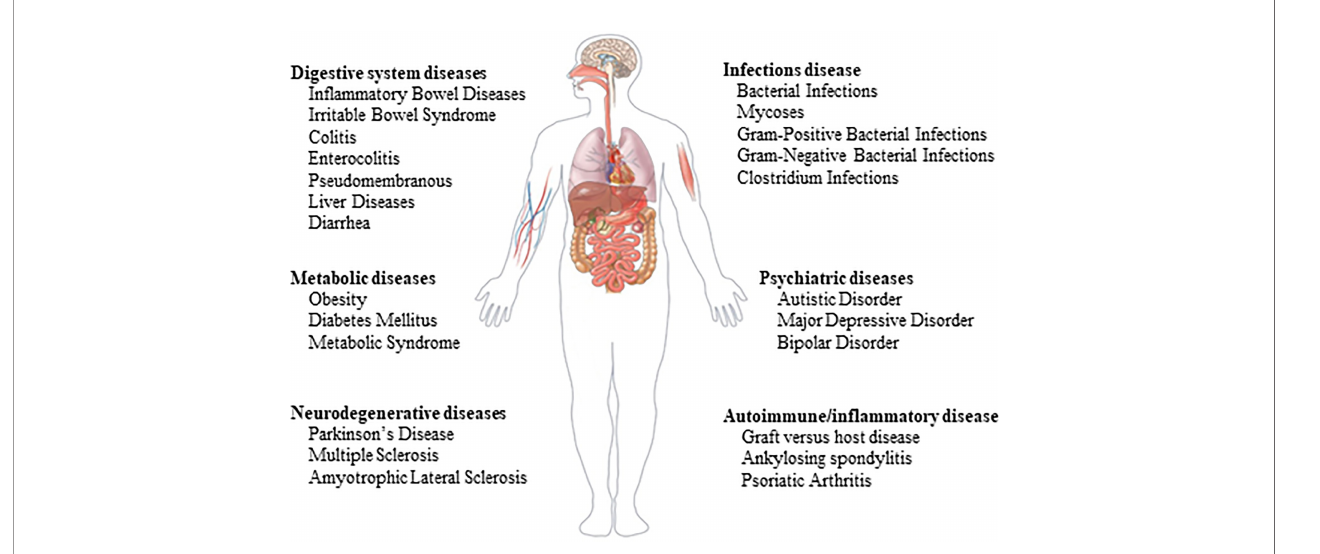
FIGURE 1 | Ongoing clinical trials on fecal microbial transplantation. The data comes from